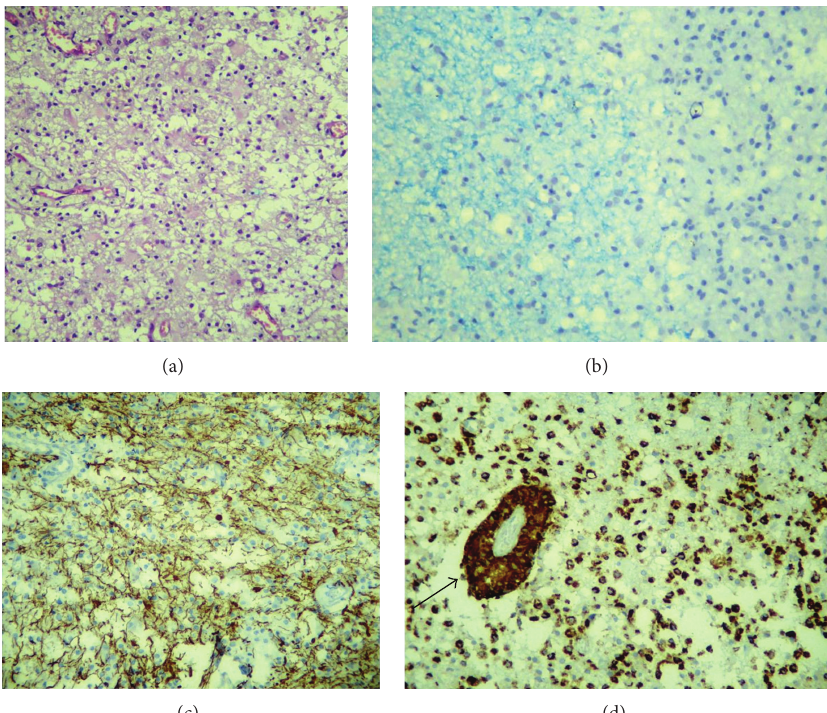
Figure 2: Histological sections of cerebral white matter of pseudotumoral multiple sclerosis. (a) Increased cellularity of the white matter due to infiltration by macrophages. Hematoxylin-eosin. (b) Junction of the normal (left) and demyelinated white matter (right), showing the well- defined limits of the demyelinated area. Luxol fast blue. (c) Relative axonal preservation in the demyelinated area. Immunohistochemistry for neurofilament. (d) Diffuse and perivascular infiltration (arrow) by macrophages. Immunohistochemistry for CD68.